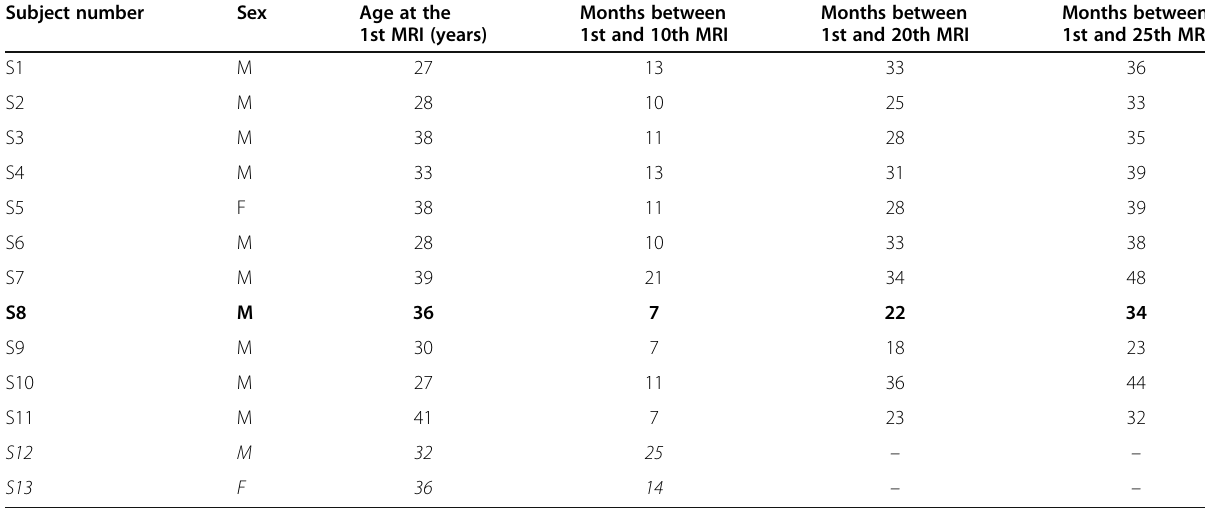
Table 1 Description of the cohort of